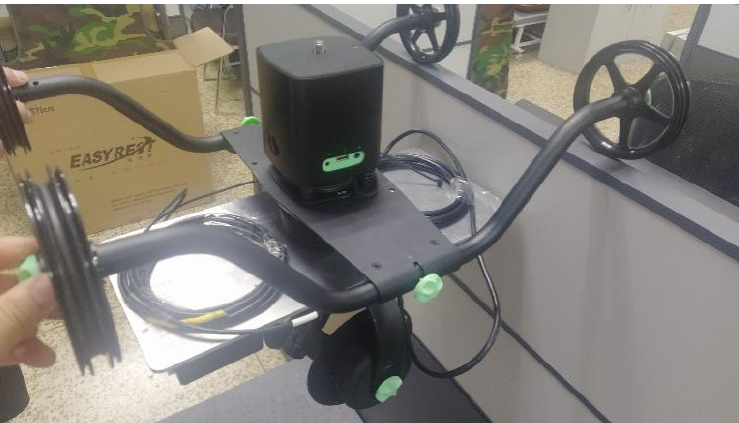
Figure 24. Experimental equipment: platform.